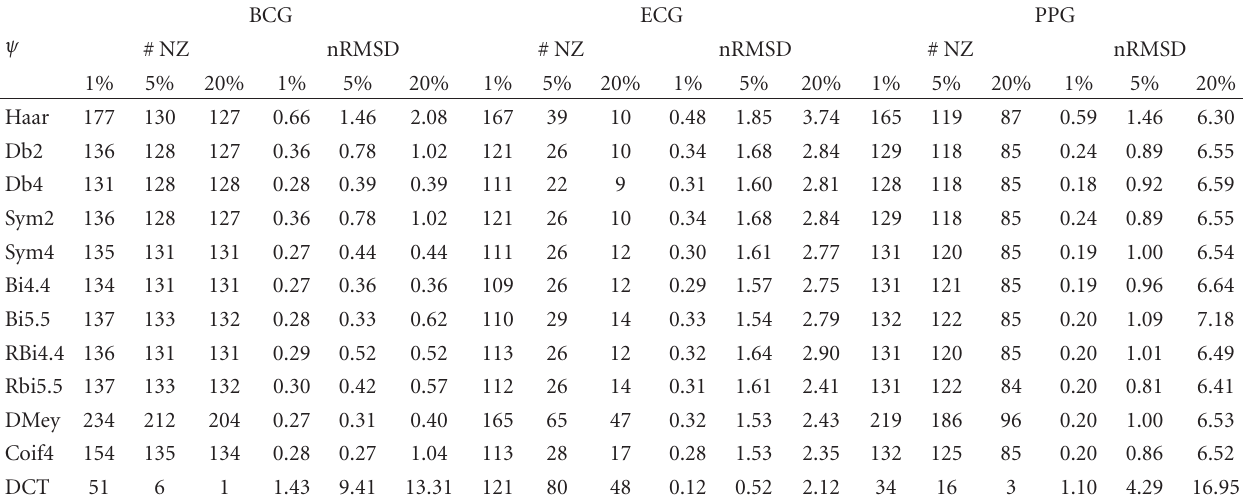
Table 1: Truncated inverse transform nonzeros and nRMSD%.